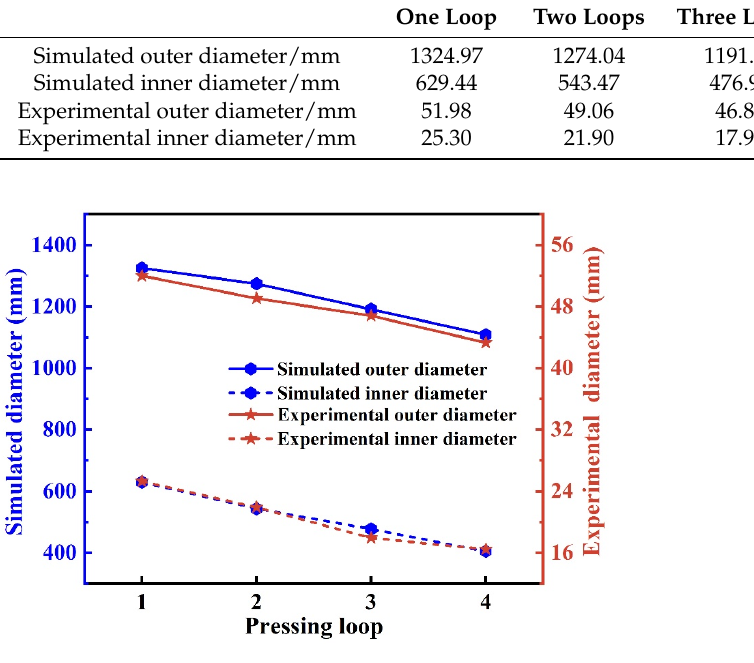
Figure 17. The simulated and experimental variations of inner and outer diameters (the experiments with a shrinkage ratio of 25:1).